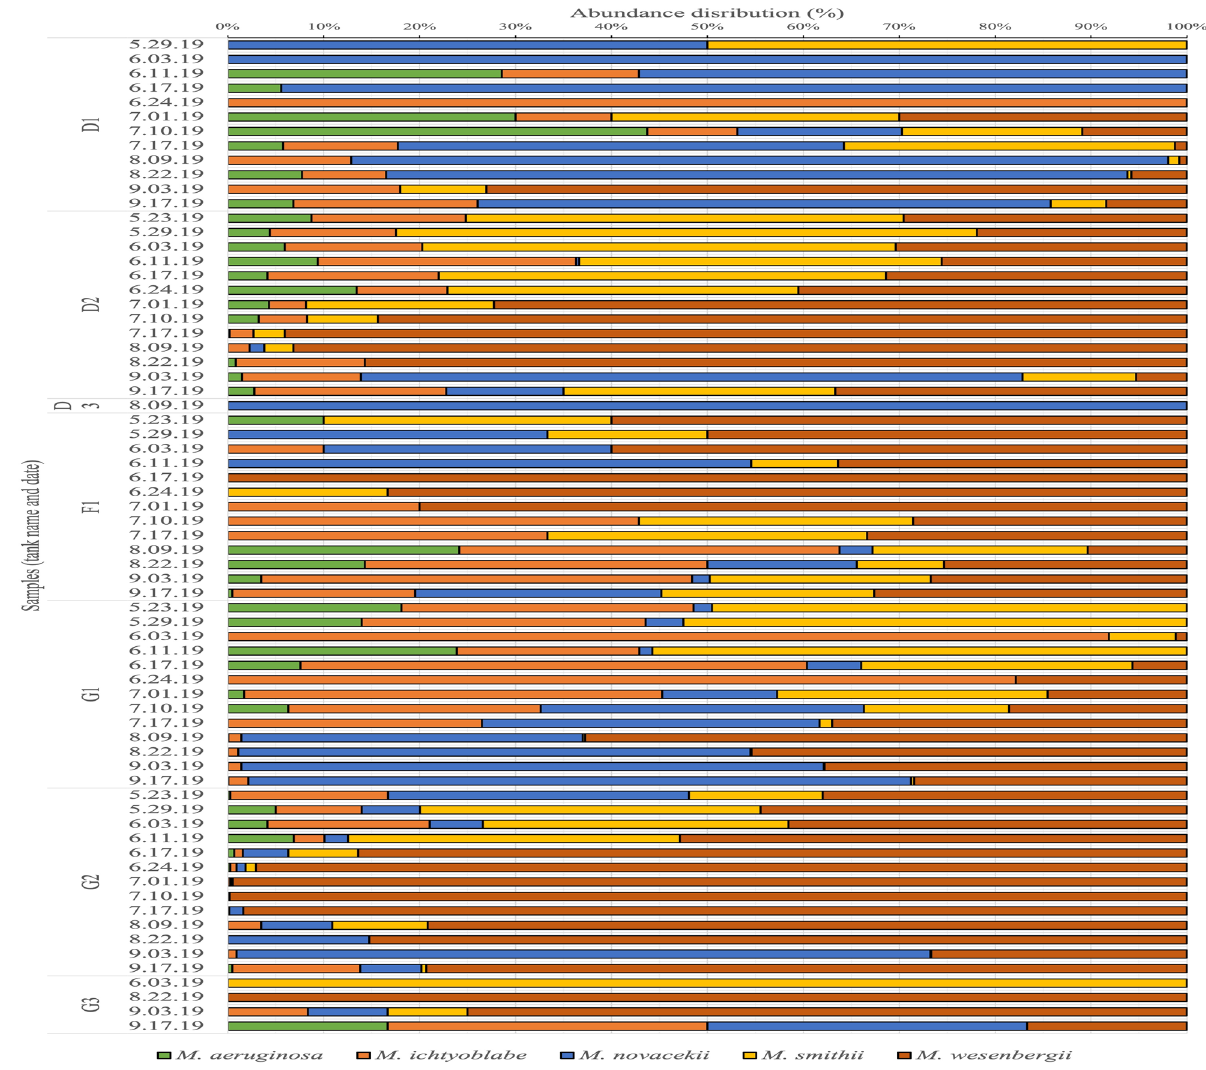
Figure 3. The distribution of Microcystis morphospecies in samples from the LMWE experiment in 2019. Grouping is based on type of tank and the date when the samples were